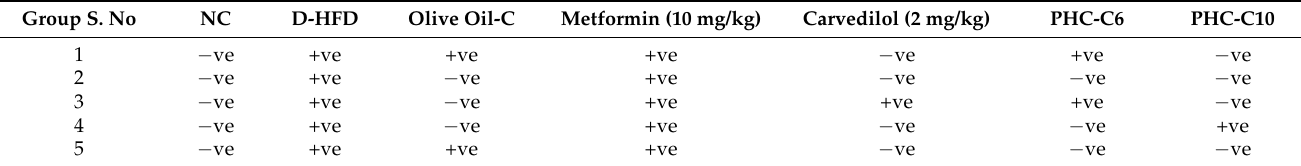
Table 4. Effect of olive oil based polyherbal combination pretreatment on Troponin-T in STZ induced diabetic cardiomyopathy.